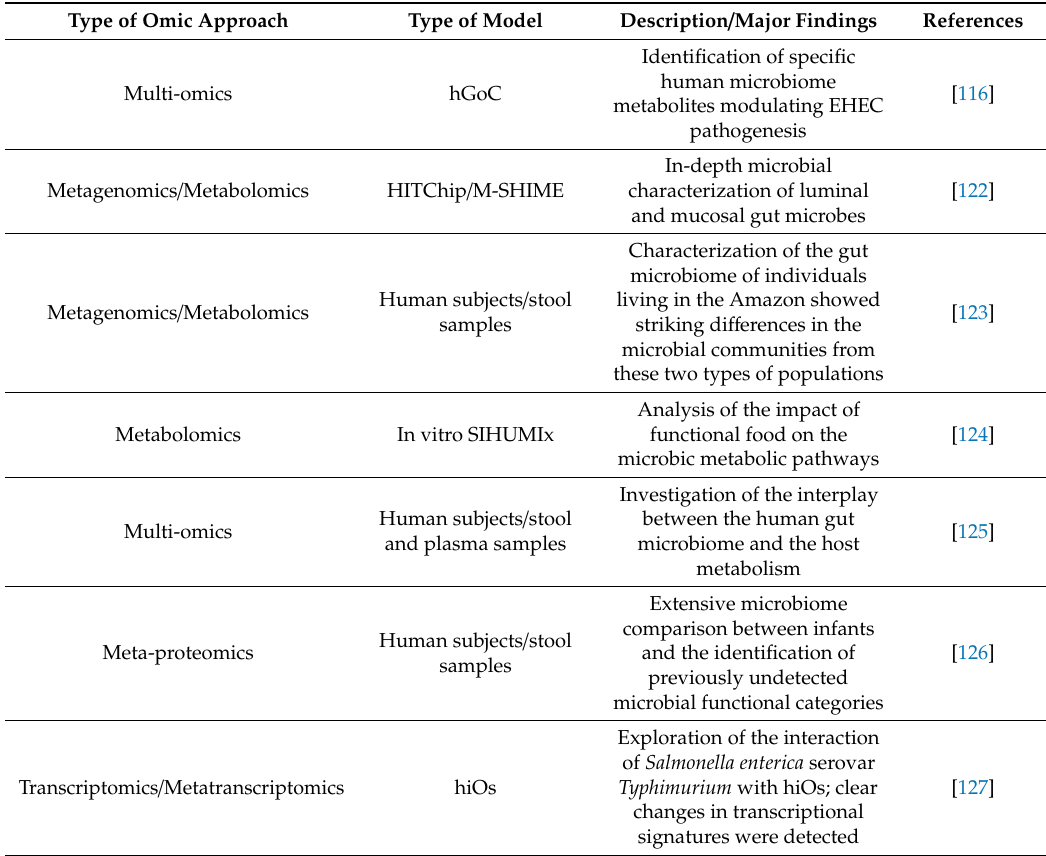
Table 1. Examples of the applications of human-based (meta)omics and multi-omics approaches to investigate host–microbiota–pathogen–nutrition